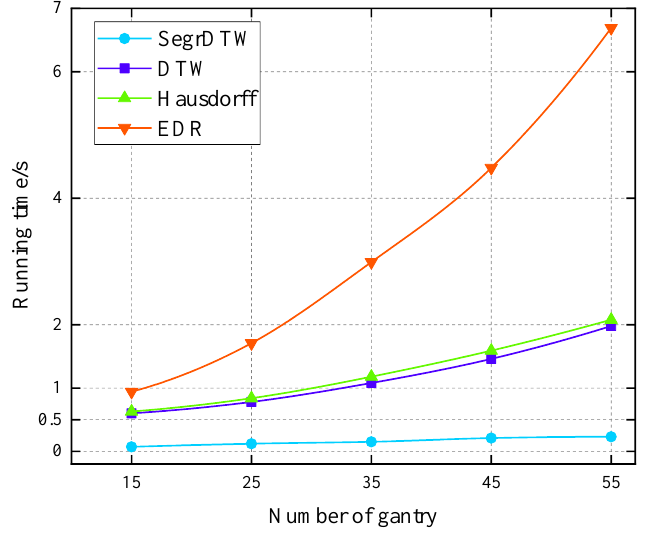
Figure 8. Number of gantries tested for run time.